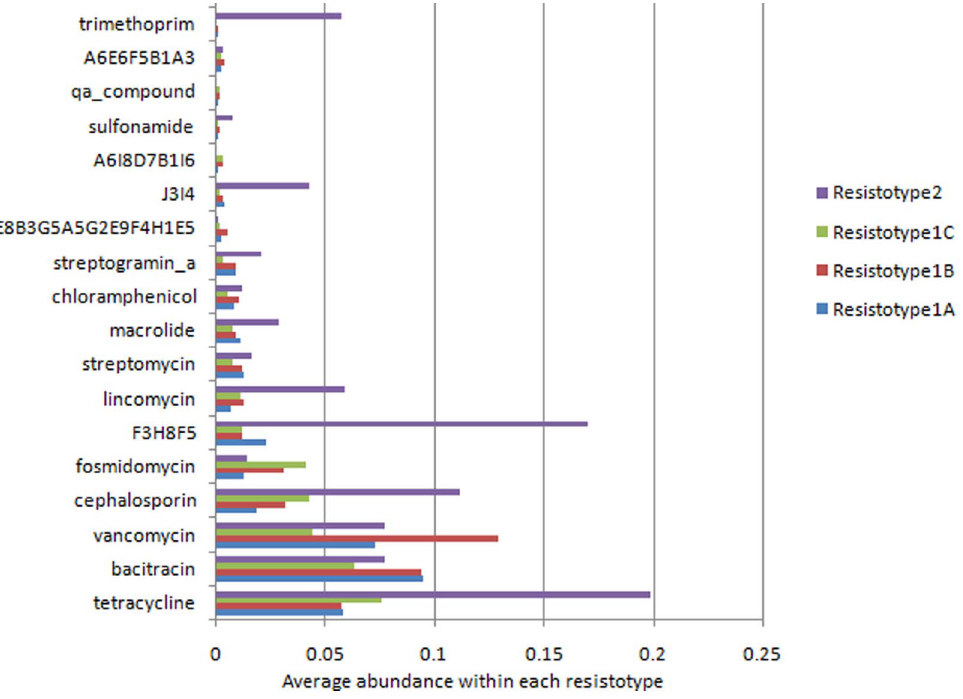
Figure 9. Abundances of the various antibiotic resistance profiles within the four different resistotypes.